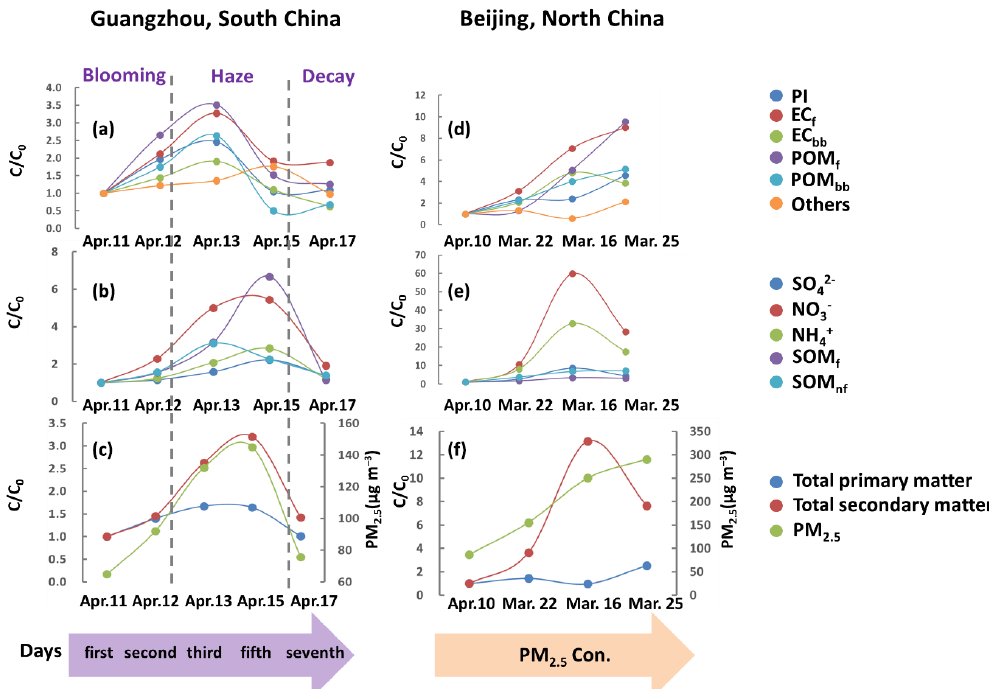
Figure 4. Dynamic changes for the primary and secondary matters in Chinese cities. Detailed concentrations and the calculation methods are shown in Table S2. The first day is 11 April in Guangzhou. For Beijing, samples are ordered by their PM 2 . 5 concentrations. All concentrations ( C ) are normalized to that of a reference day ( C o ) , i.e., the first day and the day with the lowest PM 2 . 5 concentration for Guangzhou and Beijing, respectively. PI: primary ions; POM f : primary fossil organic matter; POM bb : biomass burning organic matter; SOM f : secondary fossil organic matter; SOM nf : secondary non-fossil organic